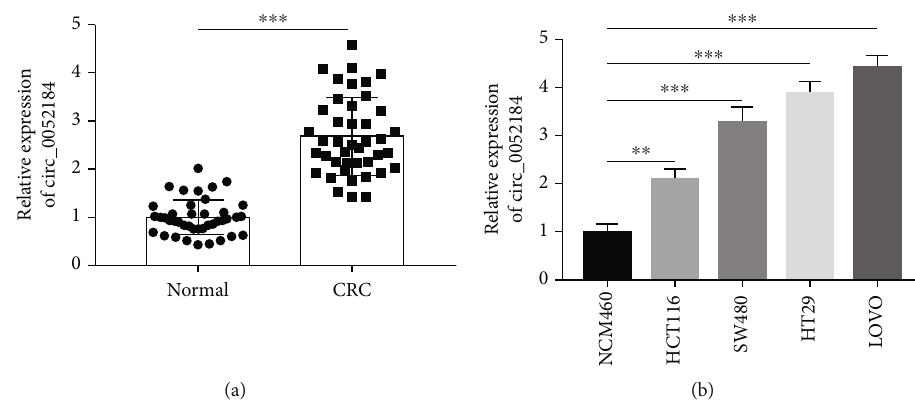
Figure 1: circ_0052184 was upregulated in colorectal cancer tissues and cell lines. (a, b) The expressions of circ_0052184 in CRC tissues ( n = 42 ) (a) and cell lines (b) were detected by qRT-PCR. ∗ p < 0 : 05 , ∗∗ p < 0 : 01 , ∗∗∗ p < 0 : 001